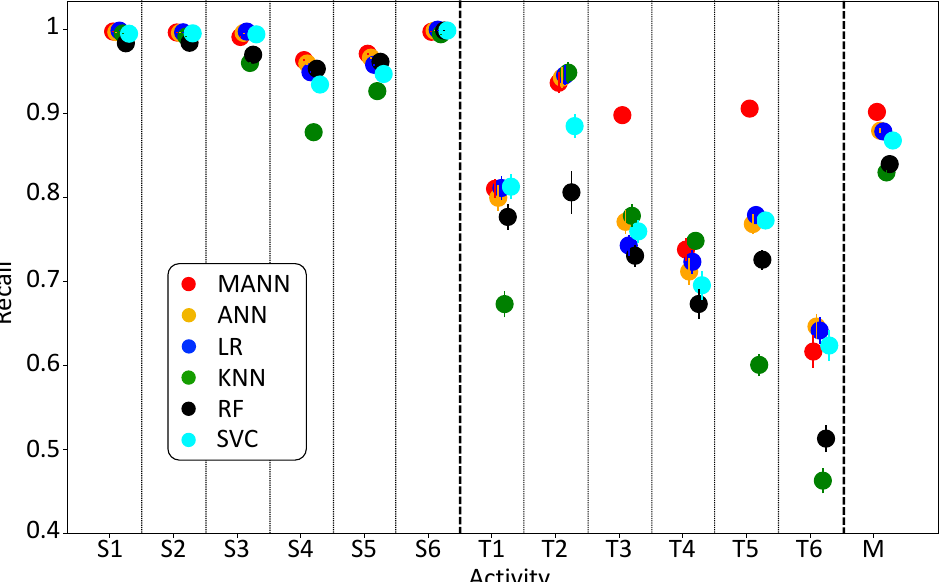
Figure 4. Comparison between classifiers’ classification performances. For each classifier, we compare the average recall related to each activity (S1: walking, S2: walking upstairs, S3: walking downstairs, S4: sitting, S5: standing, S6: laying, T1: stand-to-sit, T2: sit-to-stand, T3: sit-to-lie, T4: lie-to-sit,